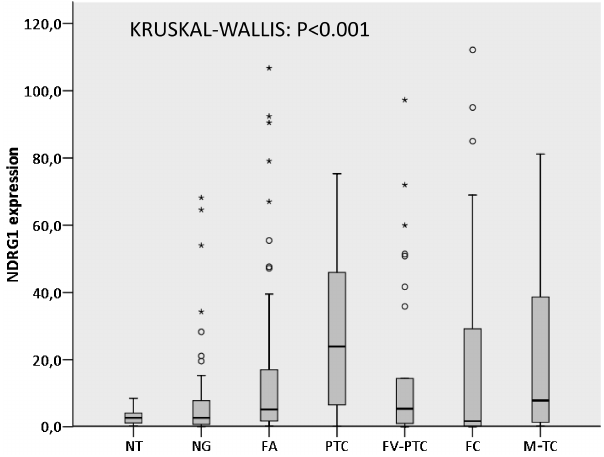
Figure 2 - NDRG1 expression in normal, benign and malignant thyroid gland lesions. Box plot shows the data of the quantita- tive immunohistochemical expression of NDRG1 for normal thyroid (NT), nodular goiter (NG), follicular adenoma (FA), classical papillary thyroid carcinoma (PTC), follicular variant of papillary thyroid carcinoma (FV-PTC), follicular carcinoma (FC), and metastases of thyroid carcinoma (M-TC) ( P , 0.001, Kruskal- Wallis test). The ‘‘o’’ and ‘‘*’’ symbols indicate outlier and extreme outlier values,